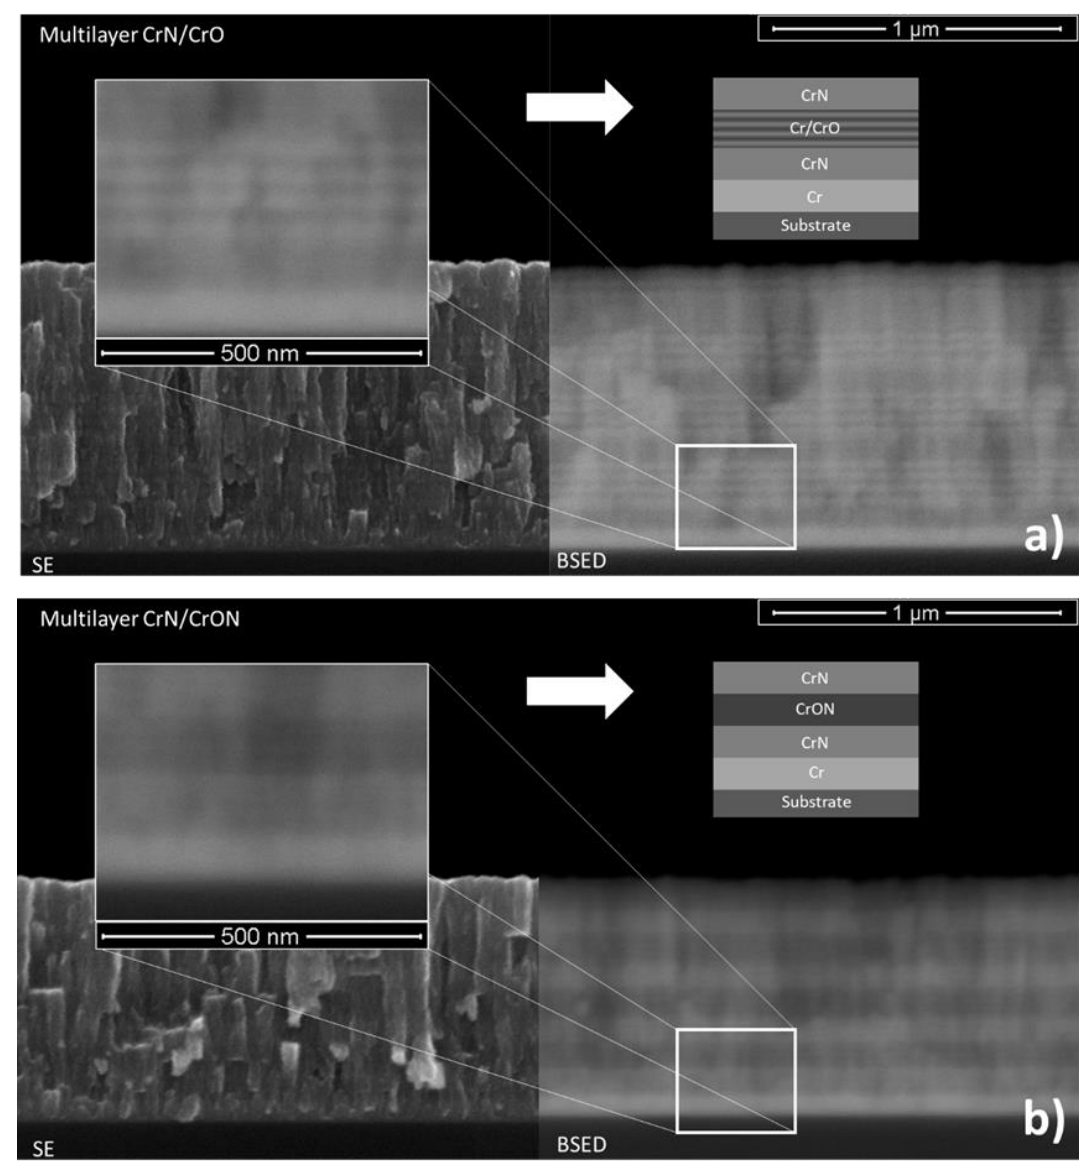
Figure 6. Cross-section SEM micrography in secondary electron ( left ) and backscattered electron modes ( right ) for ( a ) CrN/CrO and ( b ) CrN/CrON multilayer coatings.